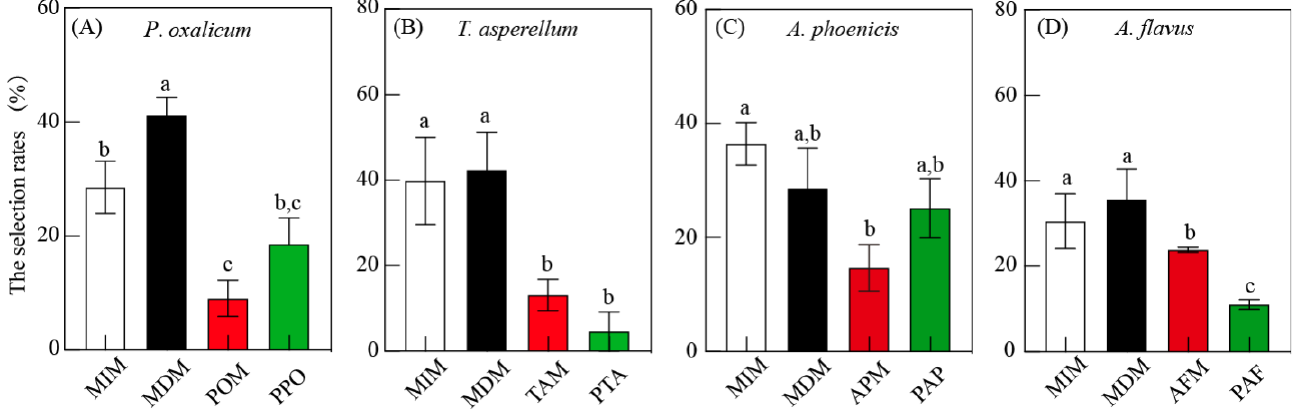
Figure 3. The selection rates of mated YPM females in four-arm olfactometer